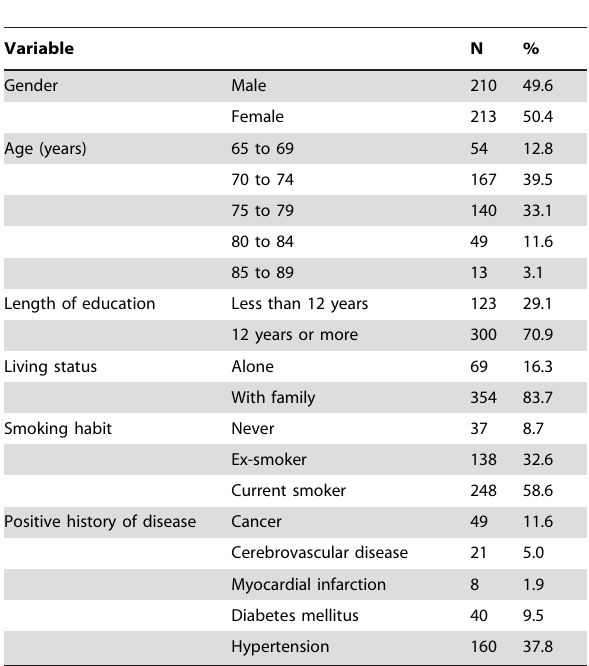
Table 1. Demographic characteristics of the subjects (N= 423).